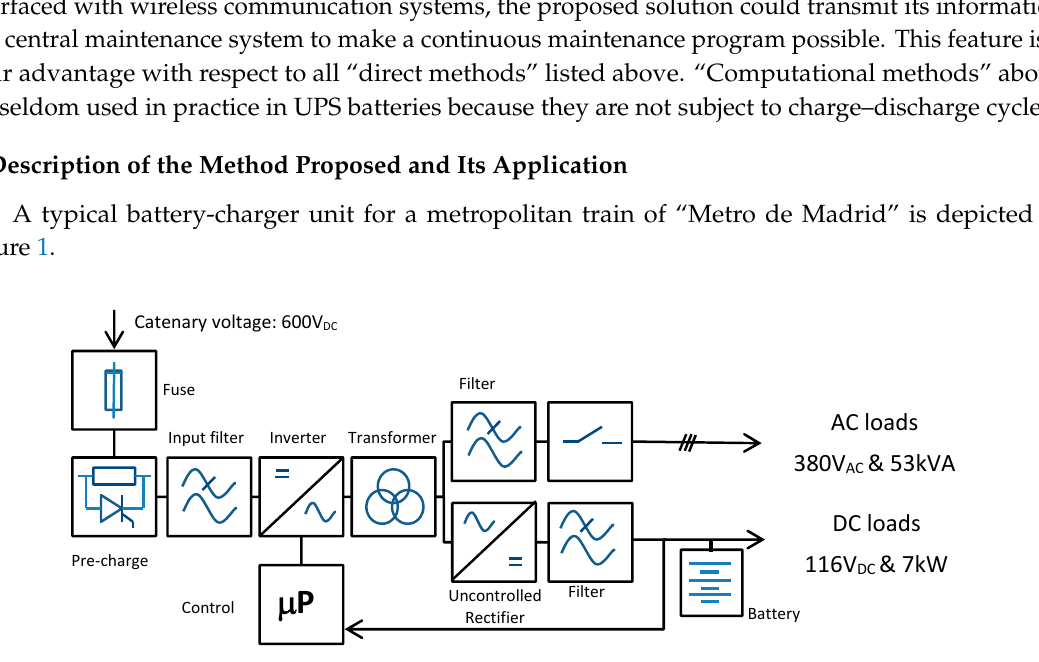
Figure 1. Diagram block of the 60 kVA converter and battery.